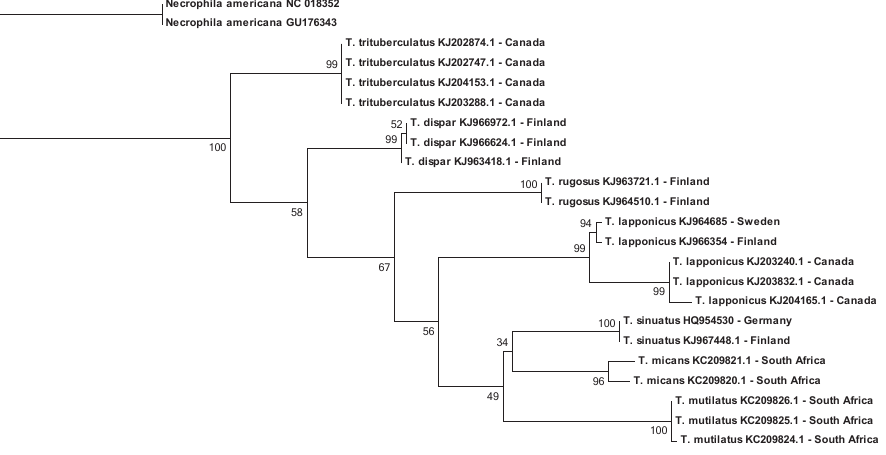
Figure 1. Maximum Likelihood phylogram with the highest log likelihood (–1507.1992) based on 360 bp of the cytochrome oxidase I gene of seven species of Thanatophilus . The code numbers following the specimens’ identifications are their GenBank reference numbers, and the numbers beside each node are the percentage of bootstrapped trees in which the node is present. Branch lengths indicate the relative number of substitutions per